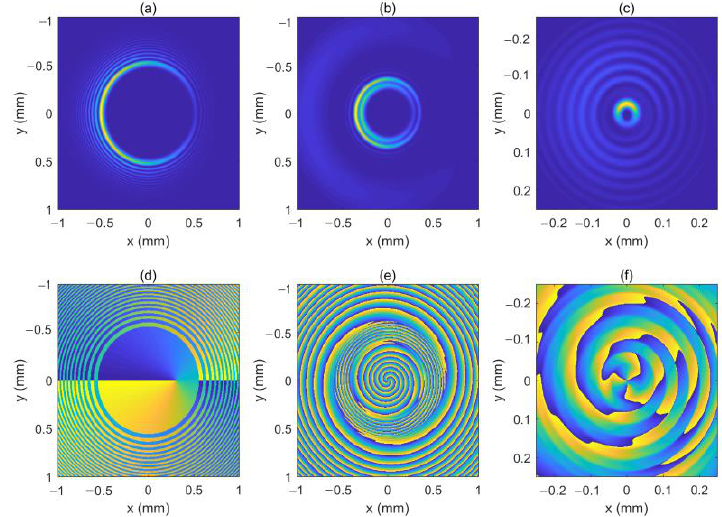
Figure 8. The intensity pattern and phase distribution of the RHCP component at different distances. ( b , c ) show the intensity pattern for z = 100 mm and z = 180 mm, respectively; ( e , f ) show the phase distribution for z = 100 mm and z = 180 mm, respectively. The intensity pattern and phase distribution of the initial beam are also shown in ( a , d ).